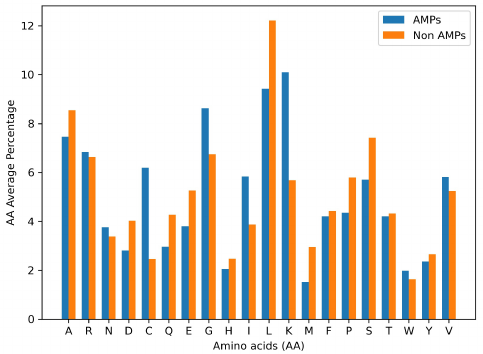
Figure 2. Amino acids distribution. Abundance of each amino acid within all sequences of AMPs and